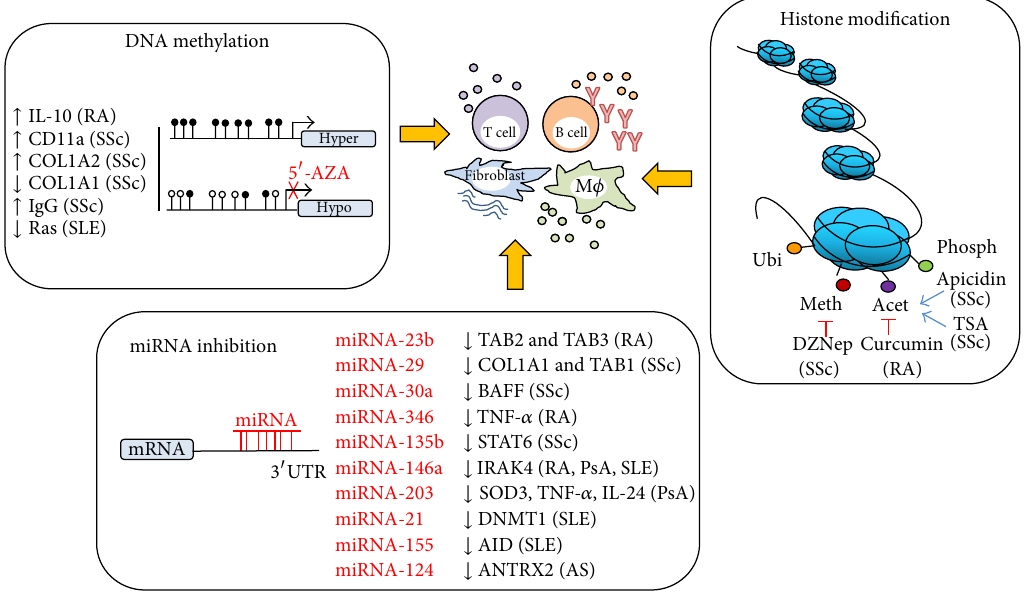
Figure 1: Epigenetic agents modulating immune response in rheumatic diseases including RA, SSc, SLE, AS, and PsA. Schematic of the epigenetic modulations represented by DNA methylation, histone modification, and RNA interference influencing immune cells (B cells, T cells, and monocytes) and fibroblasts. DNA methylation refers to covalent addition of a methyl group to the 5-position of the cytosine ring, which can be inhibited by 5 󸀠 -AZA. 5 󸀠 -AZA induces DNA hypomethylation and drives differential gene expression. Histone modifications are reversible and site-specific histone alterations including acetylation (Acet), methylation (Meth), phosphorylation (Phosph), or ubiquitination (Ubi).HistonemethylationoracetylationcanbeeitheractivatedbyapicidinandTSAorinhibitedbyDZNepandcurcumin. miRNAinhibition is a formation of miRNA-mRNA duplexes in the position of 3 󸀠 UTR. This leads gene silencing (genes in black) by specific miRNAs (in